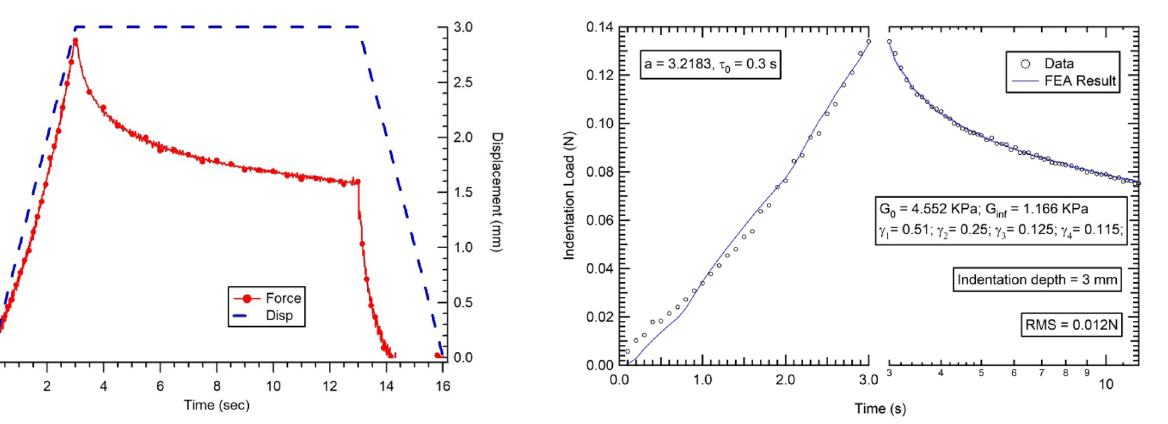
Fig. 6 Force response to displacement